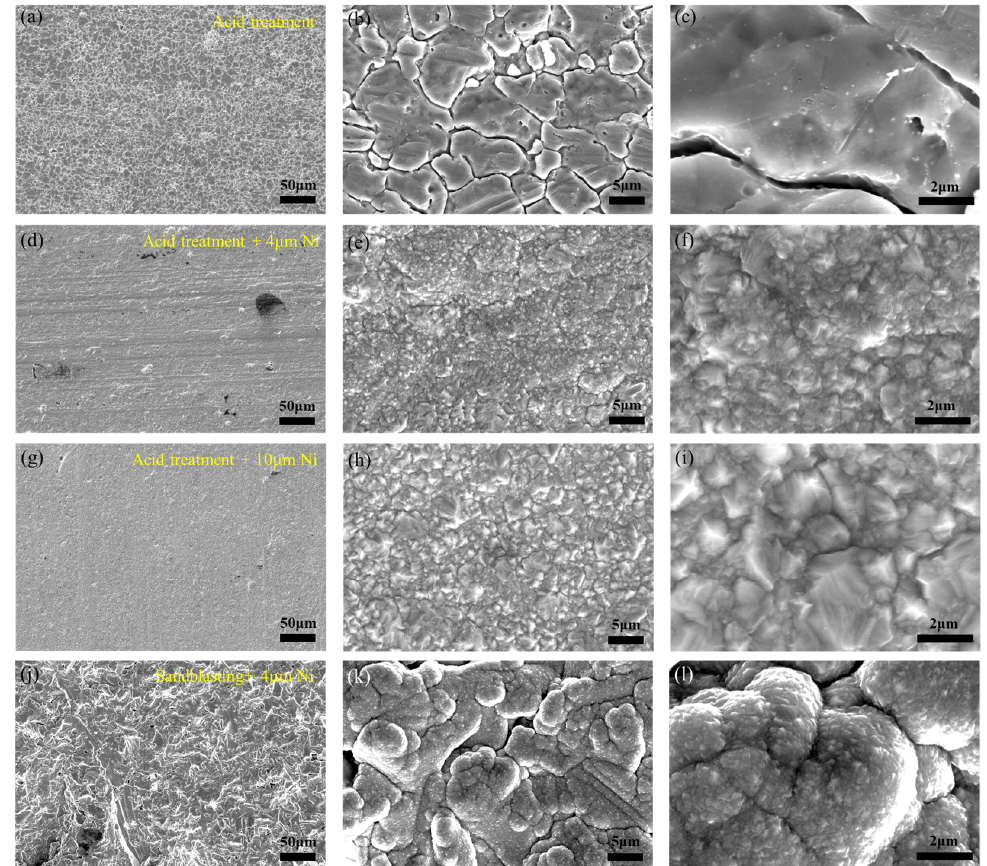
Figure 1. SEM images of 1Cr18Ni9Ti after surface treatment ( a – c ) Acid treatment, ( d – f ) acid treatment + 4 μm Ni, ( g – i ) acid treatment + 10 μm Ni, ( j – l ) sandblasting + 4 μm Ni.